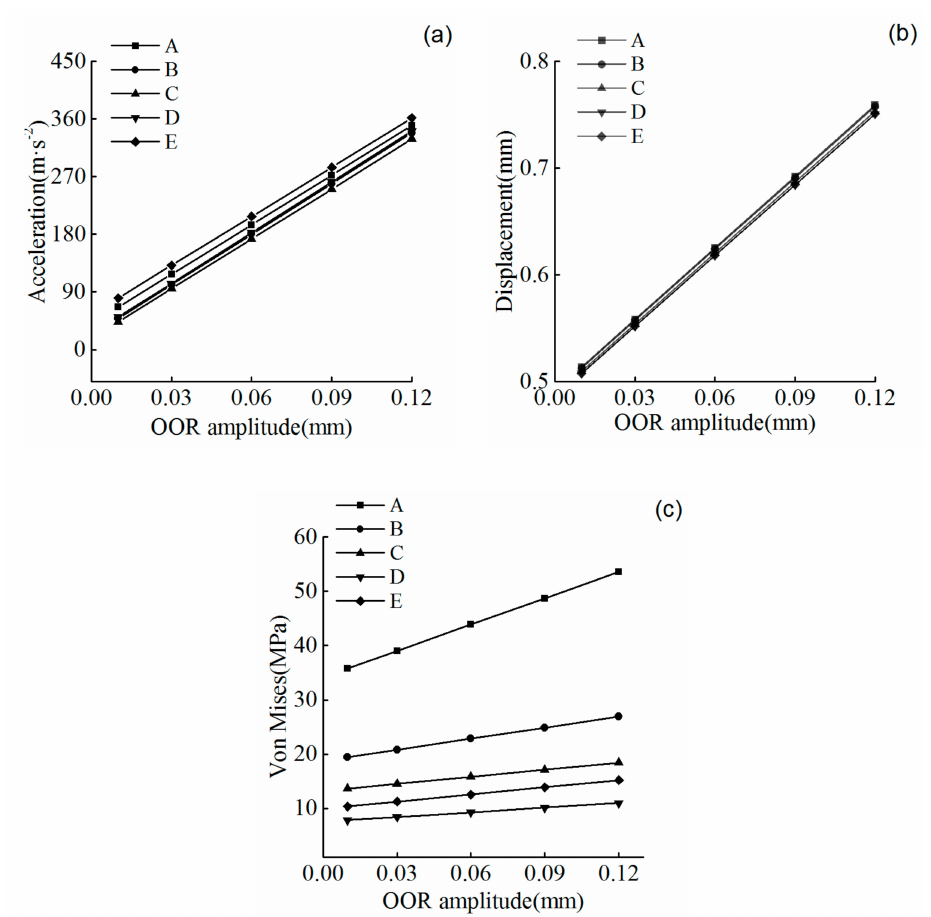
Figure8. E ff ectsofOORamplitudeonraildynamics: ( a )accelerationversusamplitude, ( b )displacement versus amplitude, and ( c ) von Mises equivalent stress versus